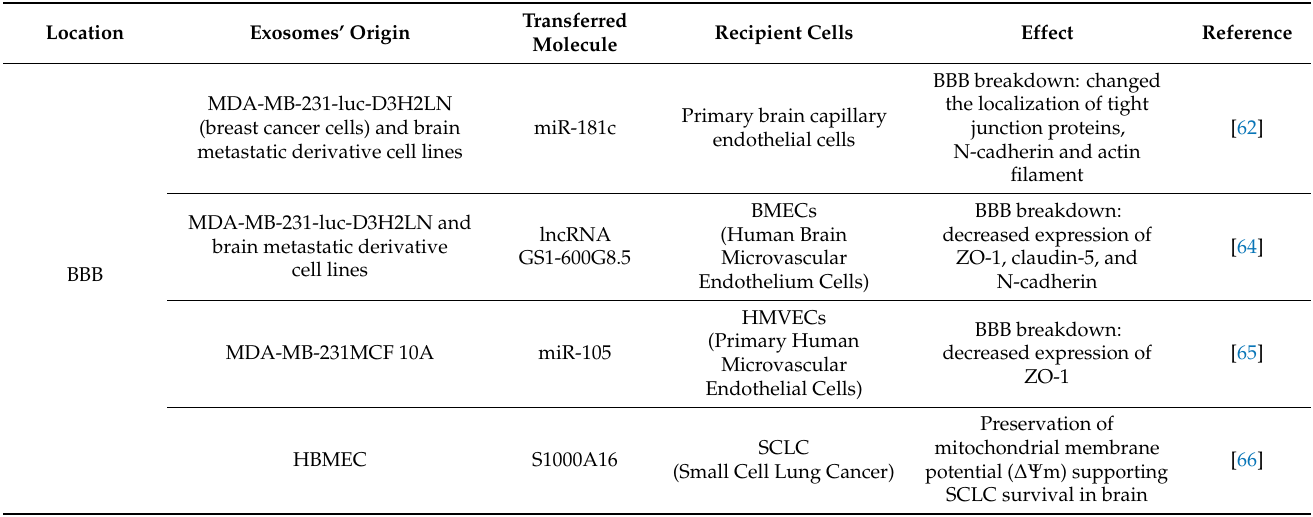
Table 1. Summary of some examples of the role of exosomes in PMN establishment in the brain. The intercellular communication mediated by exosomes is reciprocal: exosomes can transfer molecules from cancer cells to brain resident cells, or vice versa and it can facilitate PMN establishment at the level of BBB transmigration or brain parenchyma colonization.